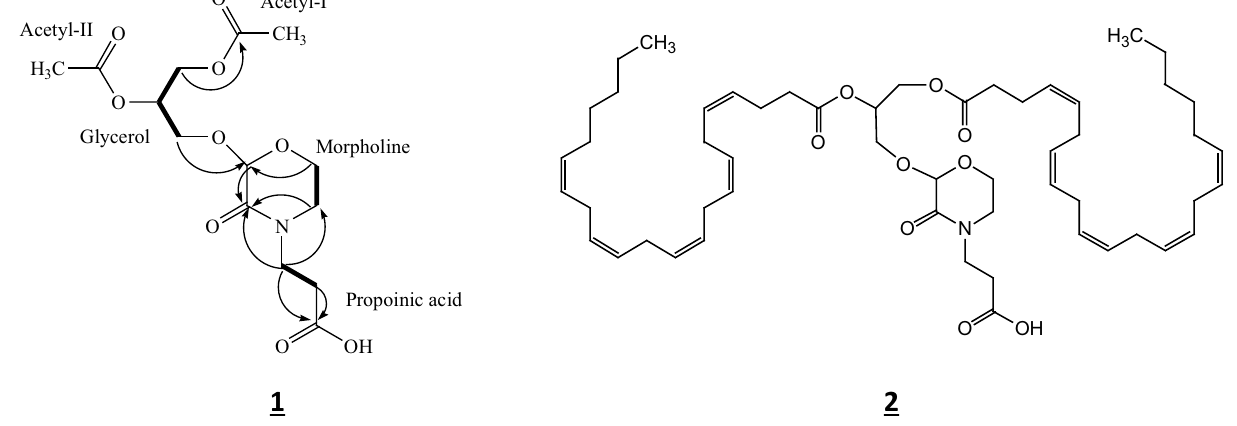
Figure 3. HMBC ( 1 H → 13 C, arrow) and COSY (heavy line) correlation of acetylated M-glyceride (1,2-di-acetylglyceryl-2 ′ - oxy-3 ′ -oxomorpholino propionic acid) ( 1 ) and structure of the major intact M-glyceride (1,2-di-docosapentaenoylglyceryl-2 ′ -oxy-3 ′ -oxo-morpholino propionic acid) ( 2